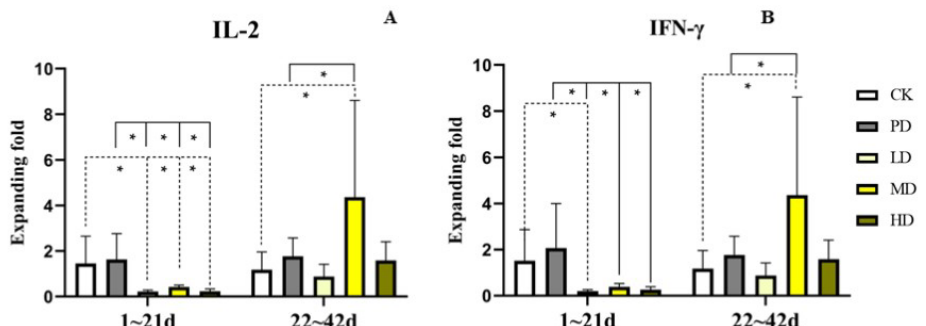
Figure 6. Effects of the fruit extract of K. coccinea on mRNA expression levels of cytokines in serum of white-feather broilers ( A ): the expression of IL-2 (interleukin-2); ( B ): the expression of IFN- γ (Interferon alpha- γ ); Note: Dotted line: compare with CK group; Solid line: compare with PD group; * indicate significant differences between groups according to the Tukey test; Supplementary Materials Table S6.